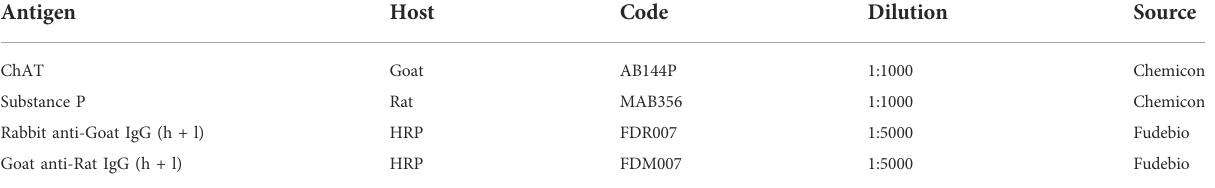
TABLE 3 Antibodies used for western